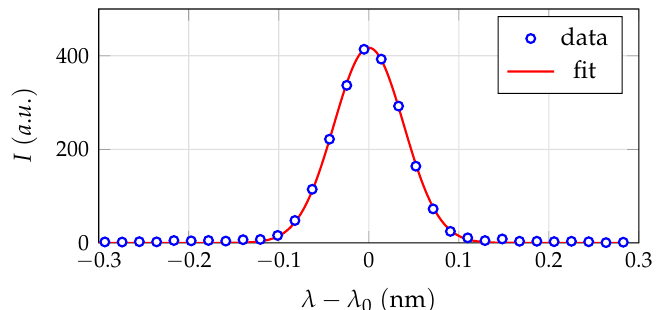
Figure 4. The instrumental profile of the spectroscopic setup determined by a Gaussian fit of a krypton emission line at λ 0 = 450.24 nm. The FWHM is 0.1 nm. The spectroscopic setup is triggered to achieve temporal resolution, with the image intensifier being synchronized to the discharge current. In order to achieve this, the working voltage is stepped down through a resistive voltage divider and triggers a DG645 pulse- delay generator made by Stanford Research Systems, Sunnyvale, CA, USA, which is used to adjust the delay. Accordingly, the microchannel plate of the camera is triggered with the pulse frequency of the plasma generator, utilizing the on-chip integration mode to achieve a better signal-to-noise ratio. The gain voltage is fixed at 800 V, while the exposure time of the microchannel plate was varied from 40 ns to 2 µs, depending on the distance from the nozzle outlet. Since the plasma system operates without a control loop, which time points can be defined. Accordingly, the width of the timeframes in Figure 2